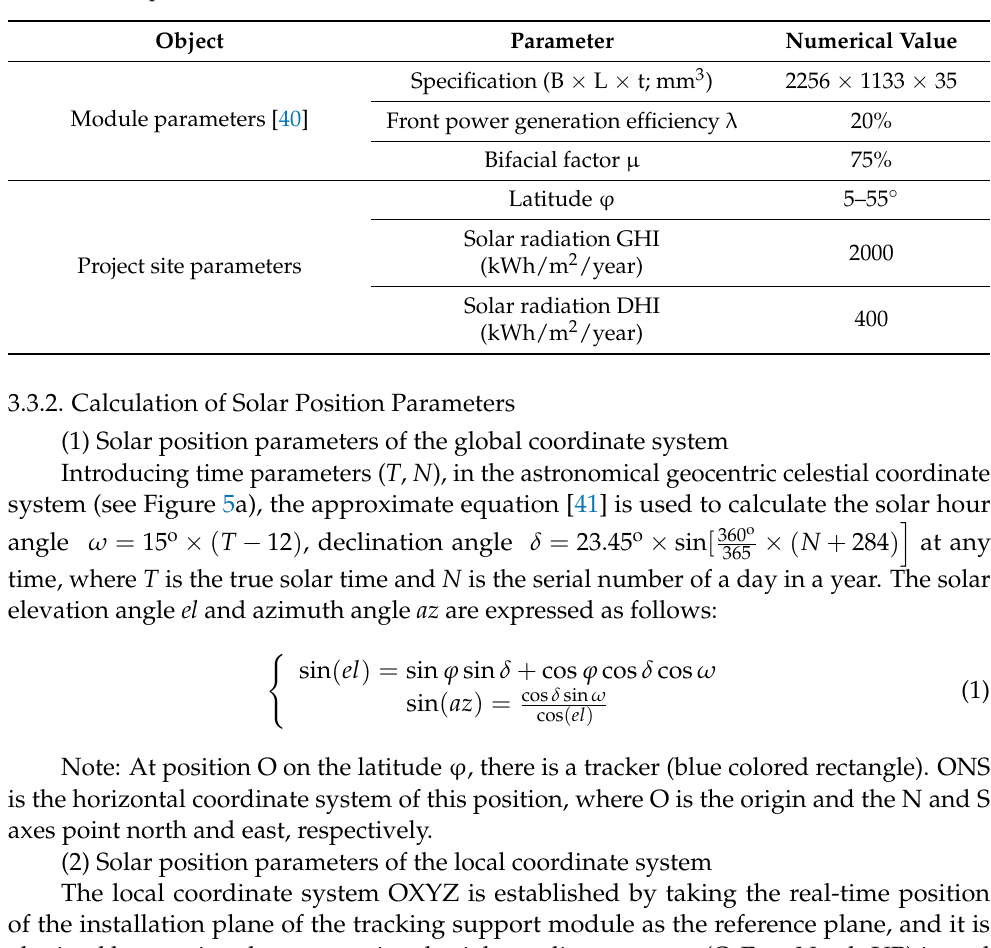
Table 1. Basic parameters of the calculation